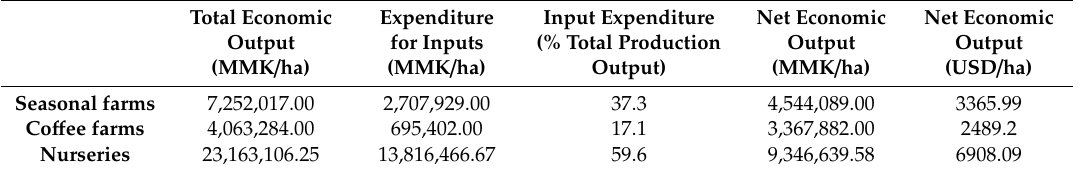
Table 2. Economic output of provisioning services provided by di ff erent types of urban